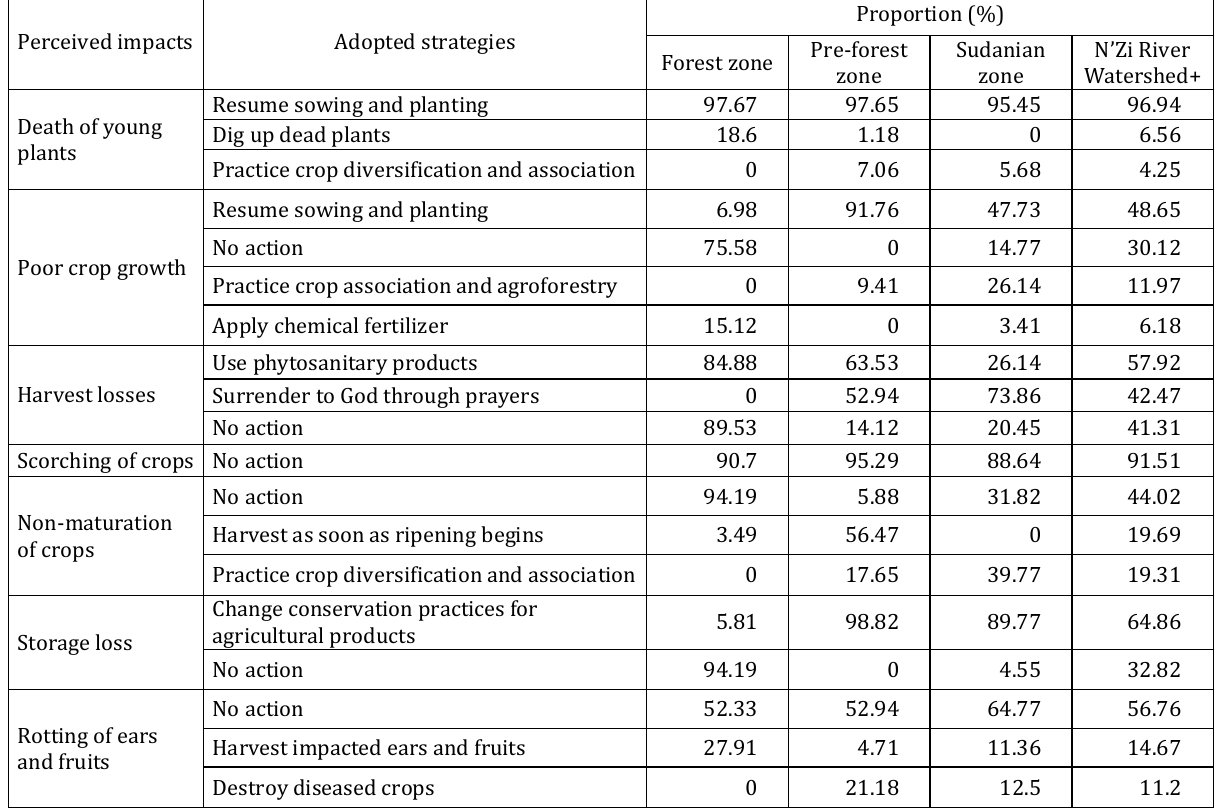
+ represents the overall statistics of the three ecoregions of the watershed